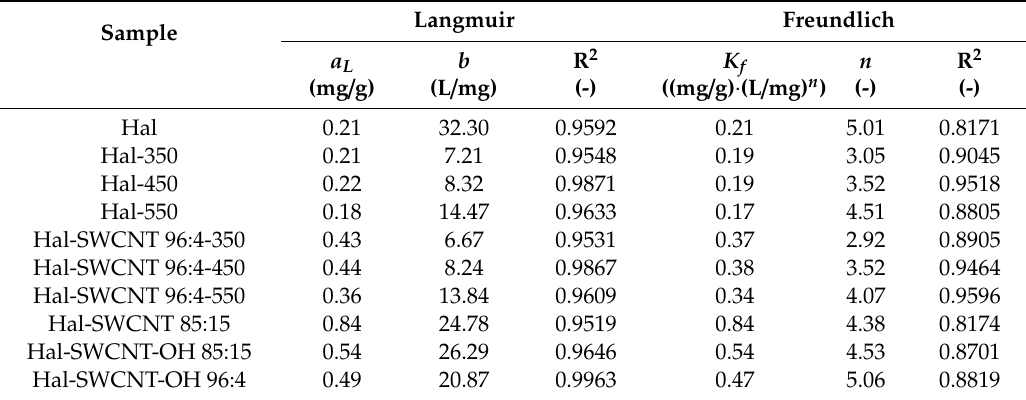
Table 5. The parameters of the Langmuir and Freundlich equations and correlation coe ffi cients for the adsorption of anthracene on Hal, Hal-350, Hal-450, Hal-550 and Hal-CNT composites.